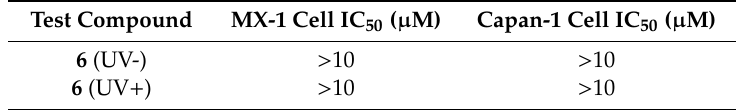
Table 4. MX-1 and Capan-1 cell inhibitory activities of compound 6 in the absence and presence ultraviolet